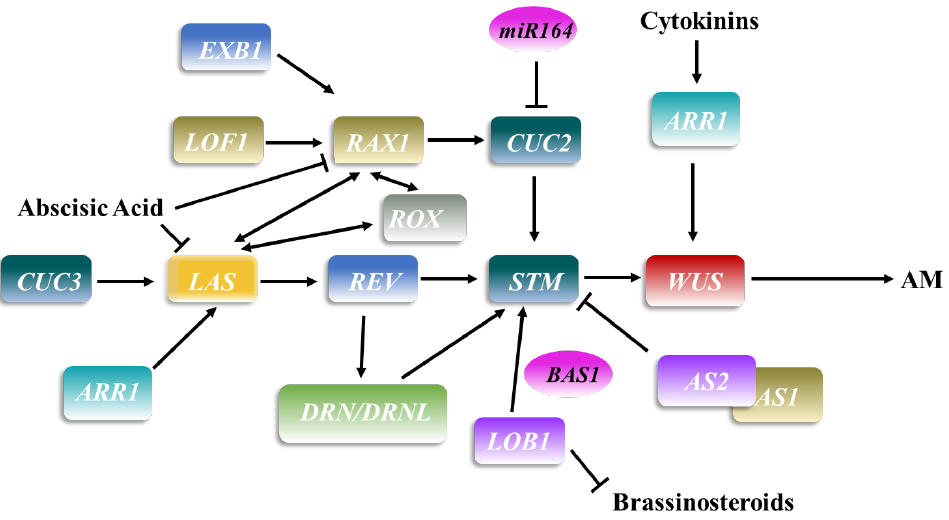
Figure 2. The pattern of transcription factors involved in regulating axillary meristem formation in Arabidopsis thaliana . The rectangular box represents a transcription factor, the same color represents the same family, and ellipses represent genes other than transcription factors. The arrow and rough line represent positive and negative regulation, respectively.